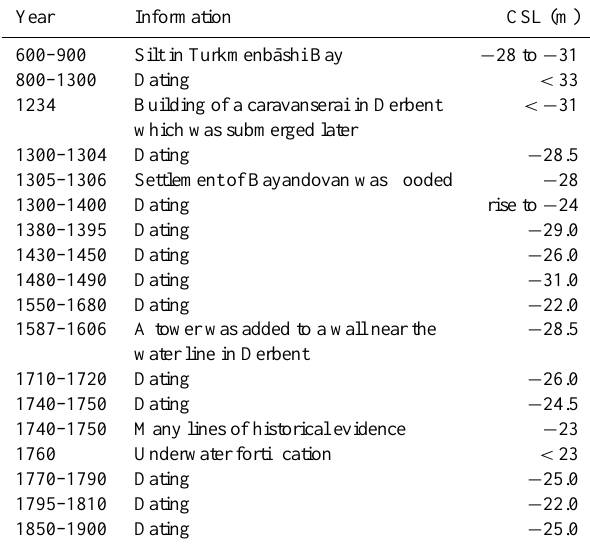
Table 5. Summary of the dates of the Caspian sea level based on his- torical documents and uncalibrated radiocarbon ages (Karpychev, 1998,